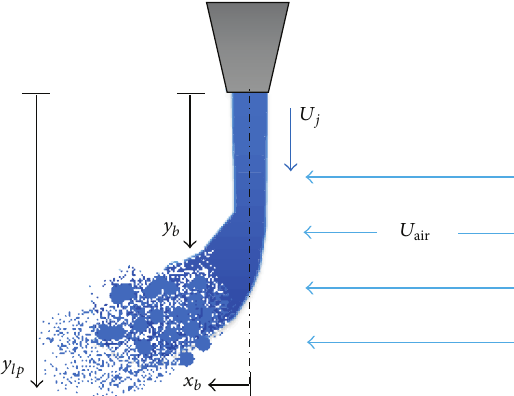
Figure 3: Sketch of liquid jet in the air